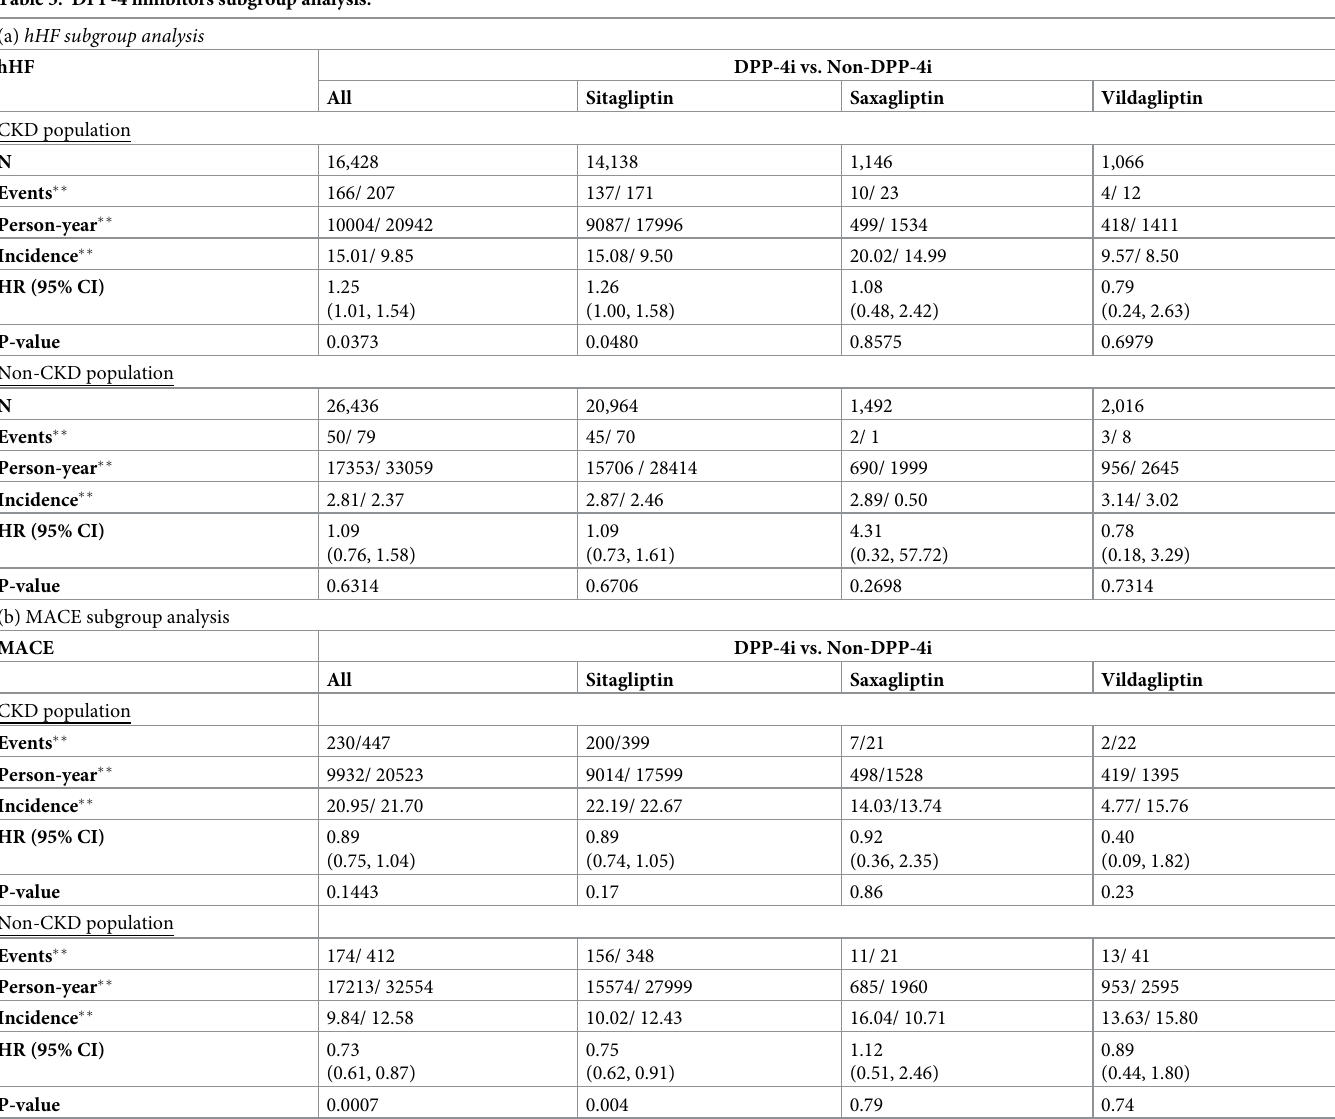
Table 3. DPP-4 inhibitors subgroup